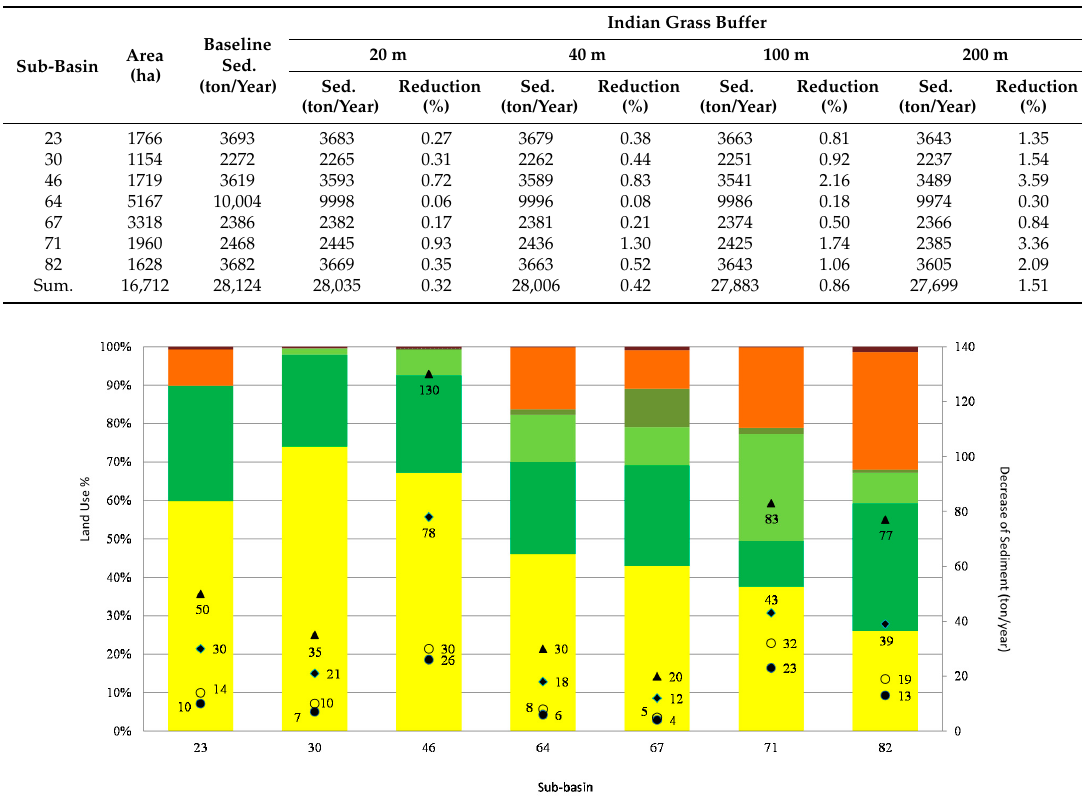
Table 4. Sediment yield results.